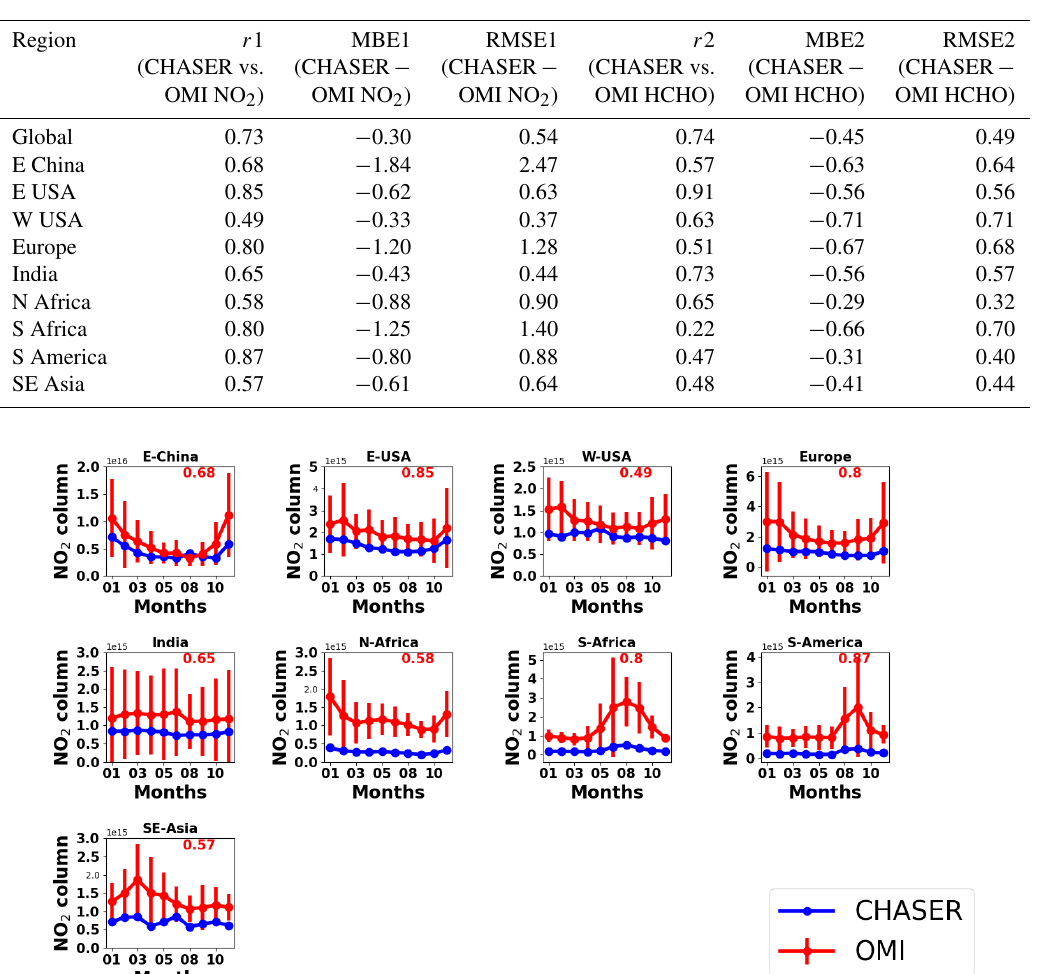
Table 5. Statistics of comparison of annual mean NO 2 and HCHO columns between CHASER and OMI. MBE1 and MBE2 are the respective mean bias errors. RMSE1 and RMSE2 are the respective root mean square errors. r 1 and r 2 signify the respective spatial correlation coeffi- cients. The units of MBE1 and RMSE1 are × 10 15 moleculescm − 2 . MBE2 and RMSE2 values are in the units of × 10 16 moleculescm − 2 .